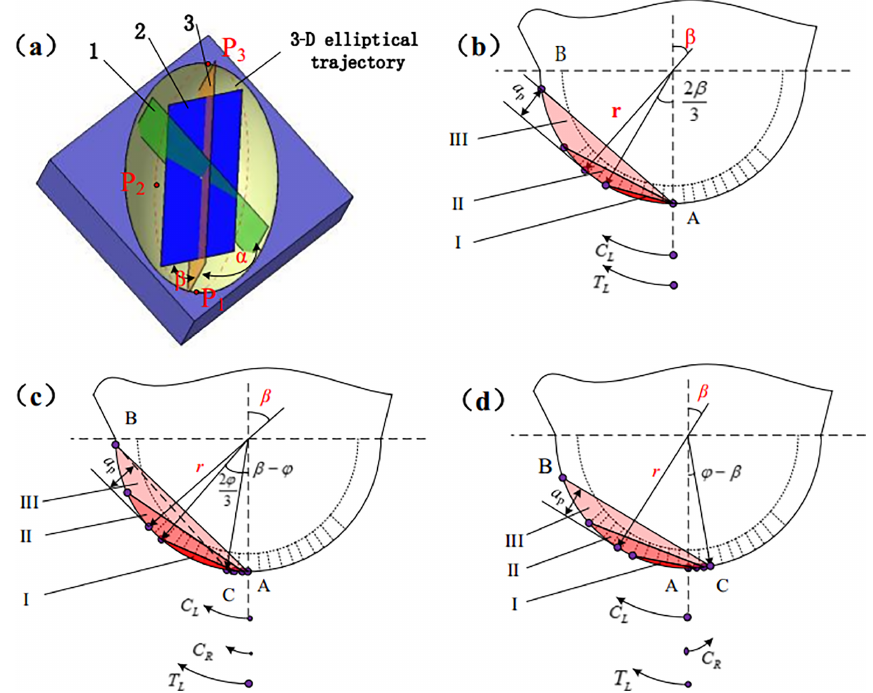
Figure 4. Diagrams of vibration tool trajectory of 3-D EVC and shift of contact marginal points.